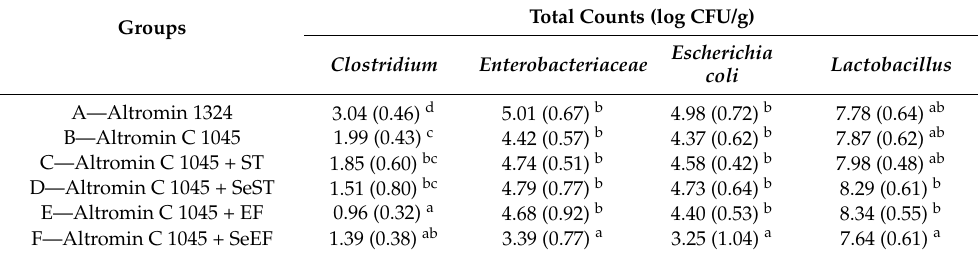
Table 8. Effects of the experimental diets on the intestinal bacterial groups.